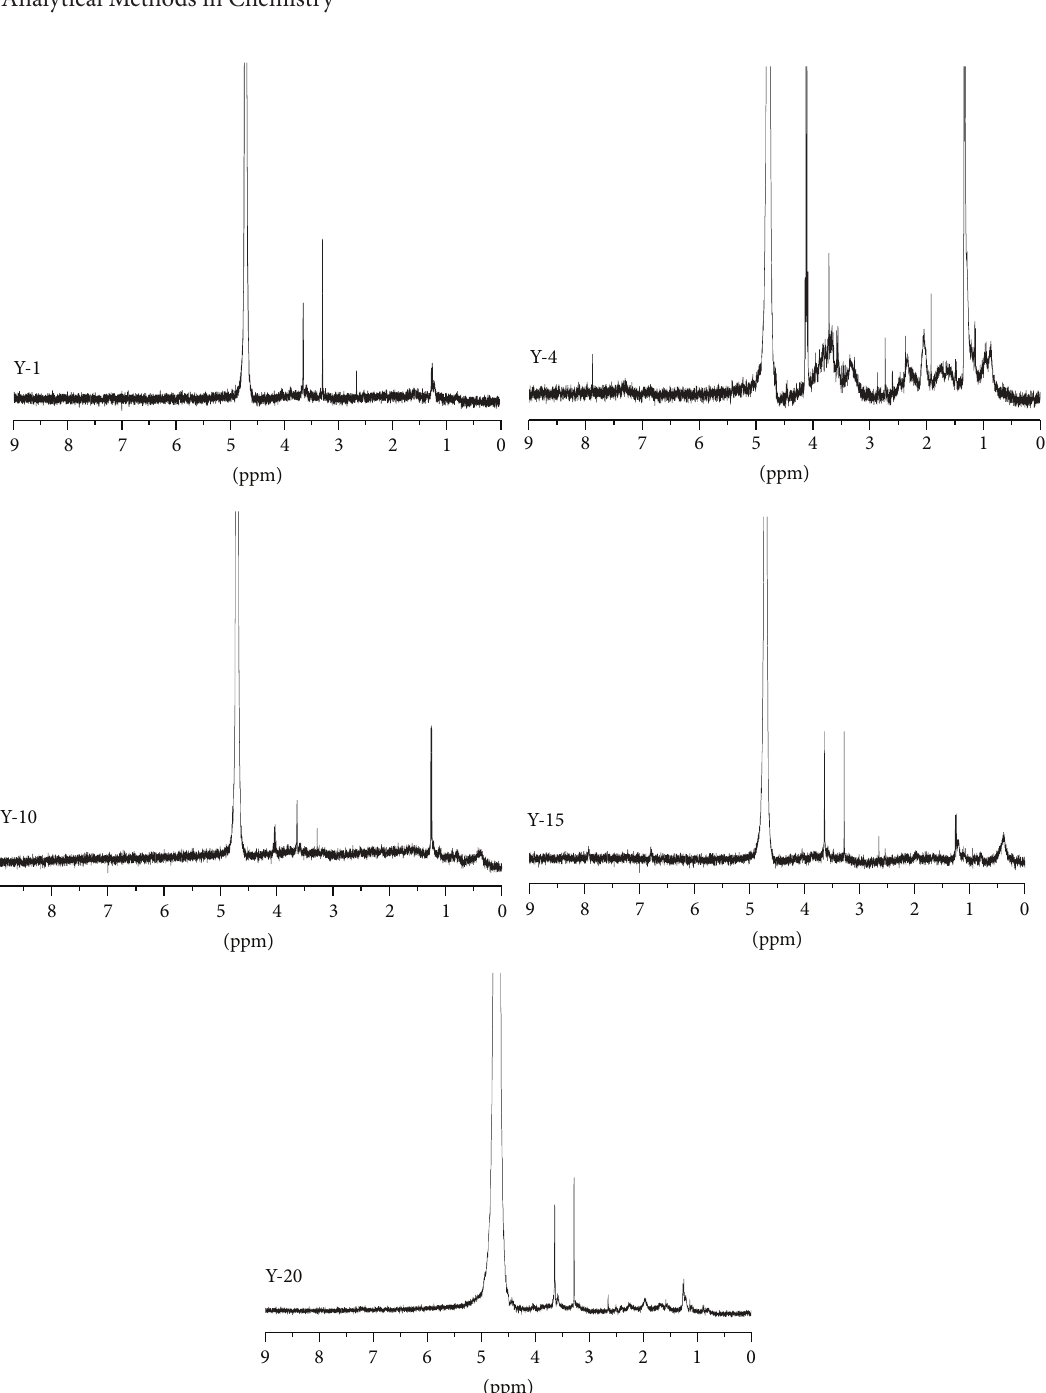
Figure 4: 1 H NMR spectra of DOM in the extracted samples of the five sampling